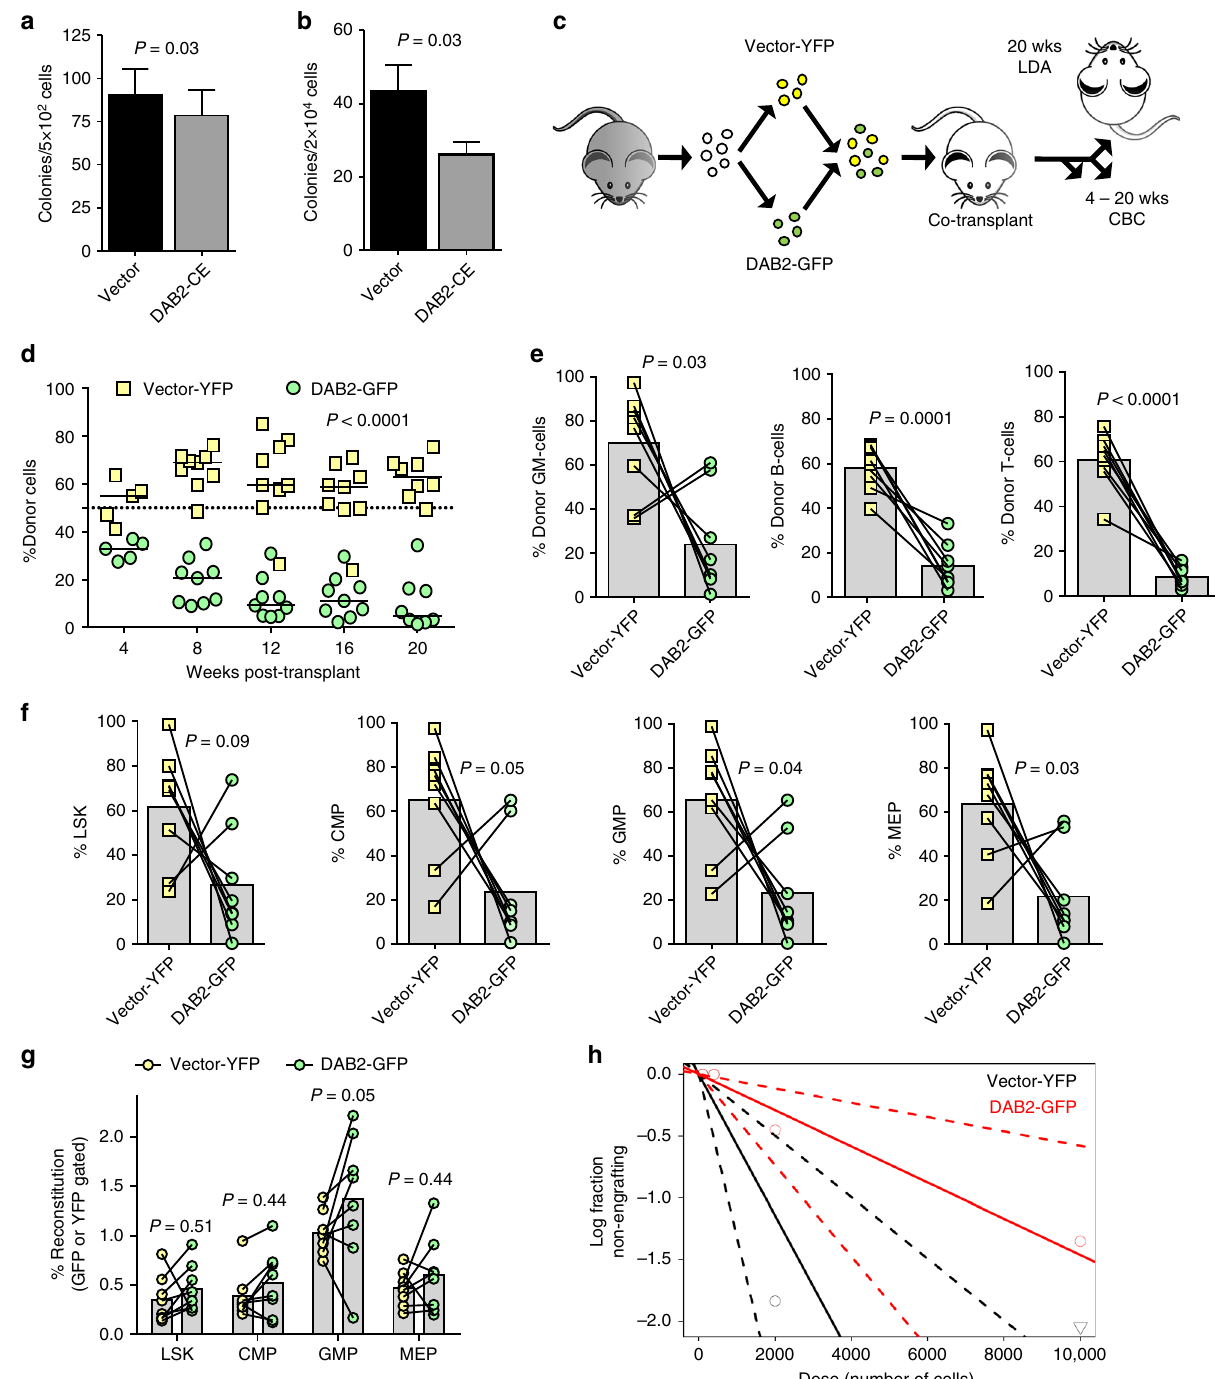
Fig. 4 DAB2 regulates HSPC function in vivo. a Colony-forming unit (CFU) analysis of constitutively expressing DAB2 (DAB2-CE) marrow (mean ± SEM, n